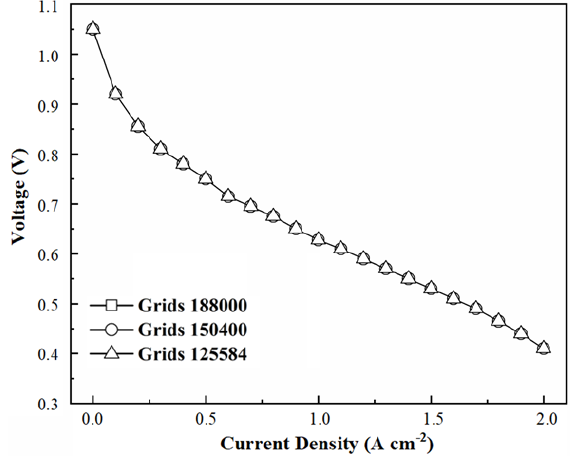
Figure 2. Polarization curves under different grid numbers.